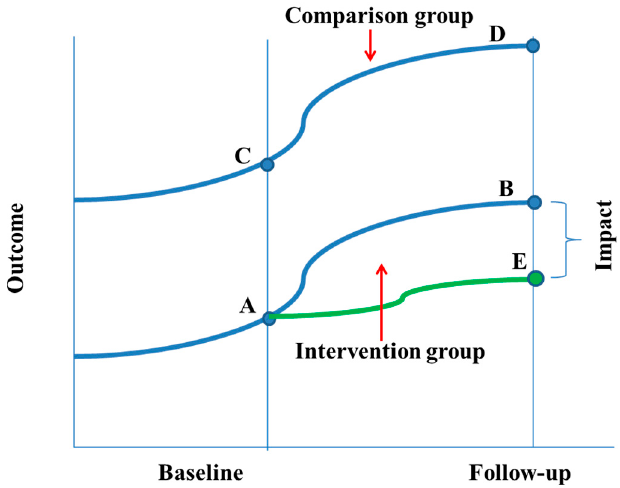
Figure 2. Difference in differences.